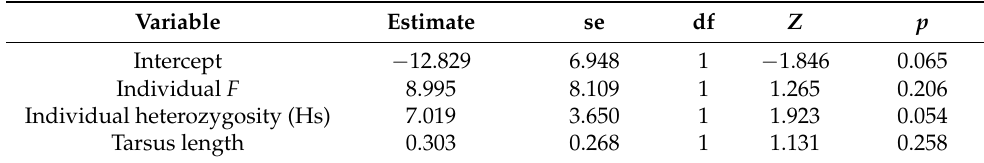
Table 2. Results of the generalized linear mixed models (GLMMs) of female-quality influence on the probability of double brooding.